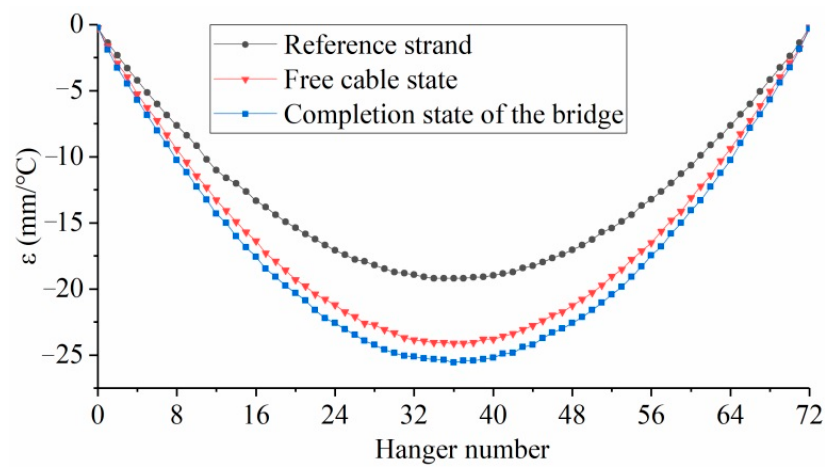
Figure 14. Comparison of the average temperature sensitivity values for every hanging point elevation on the main span cable under various constructional conditions.